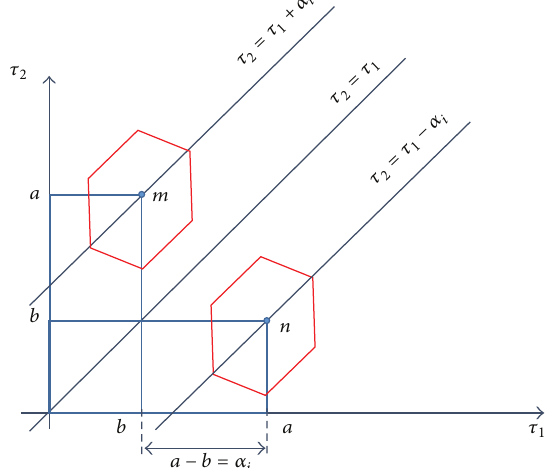
Figure 4: Graphical determination of 𝛼 𝑖 values.